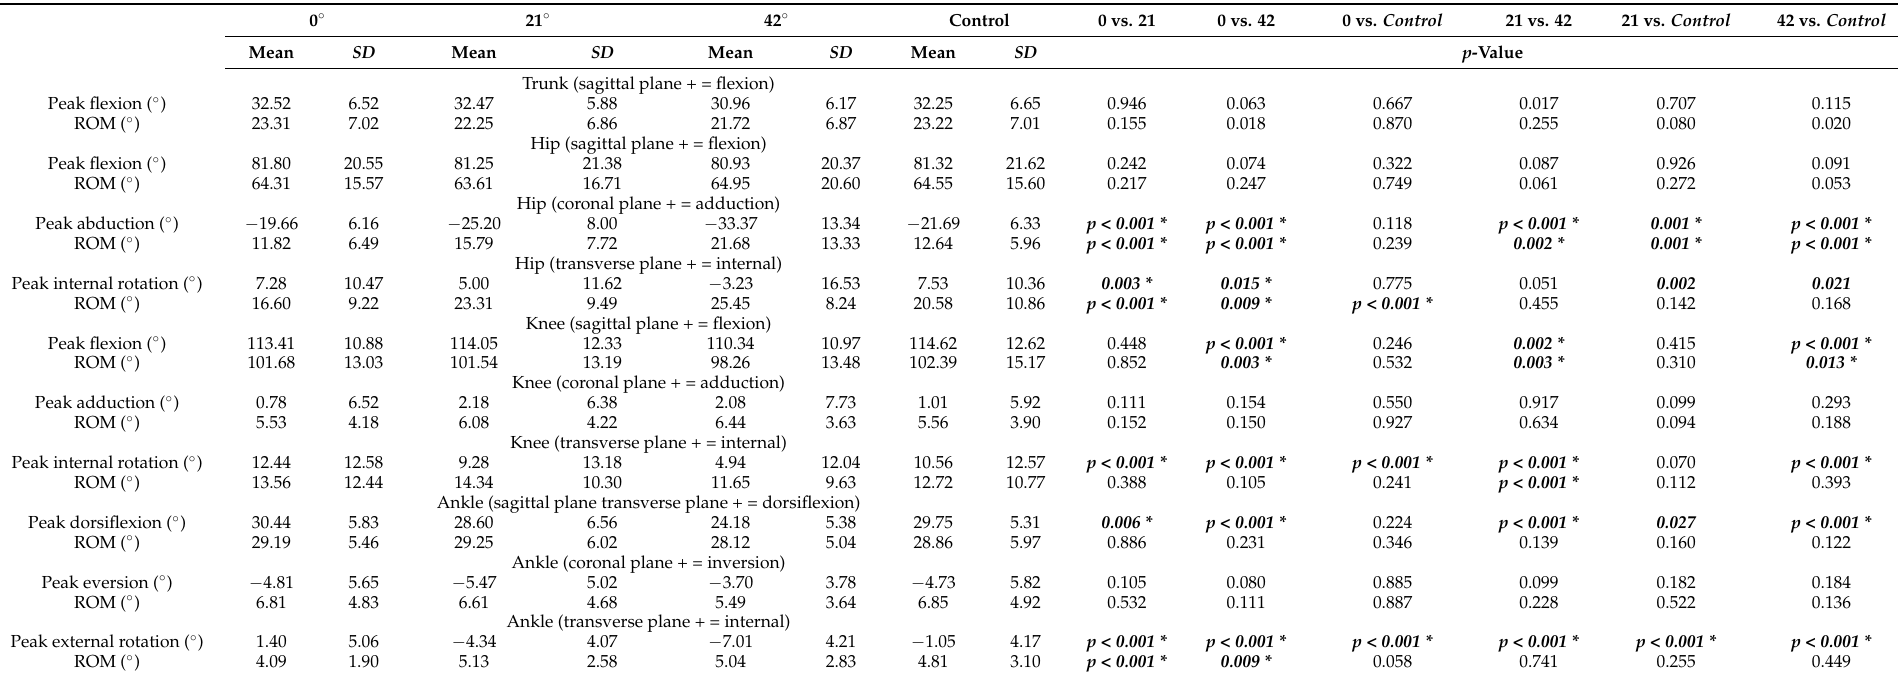
Table 7. Kinematic parameters (mean ± SD) and statistical comparisons as a function of each experimental